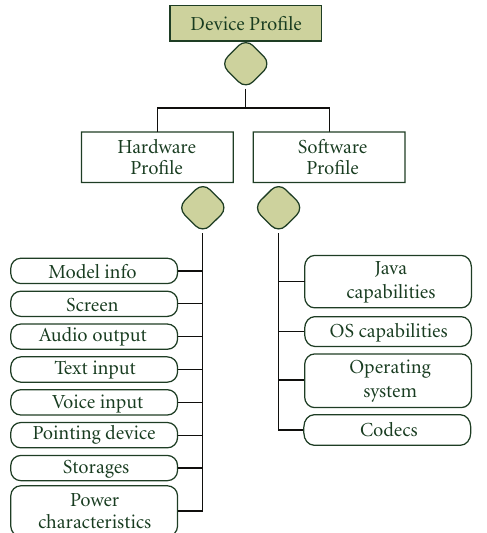
Figure 2: The Device Profile as a composition of Hardware and Software